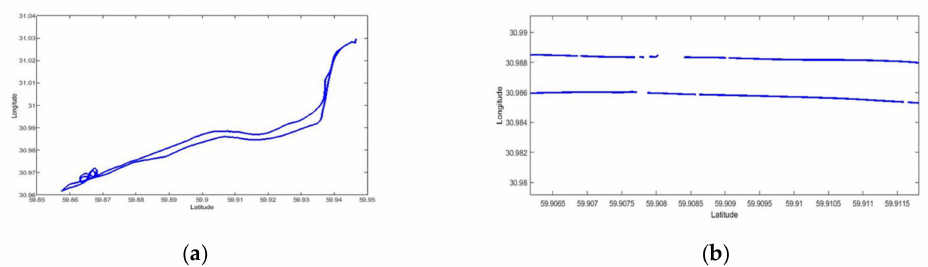
Figure 3. Vessel trajectory, obtained from the first antenna ( a ), vessel trajectory under the bridge, obtained from the first antenna ( b ).